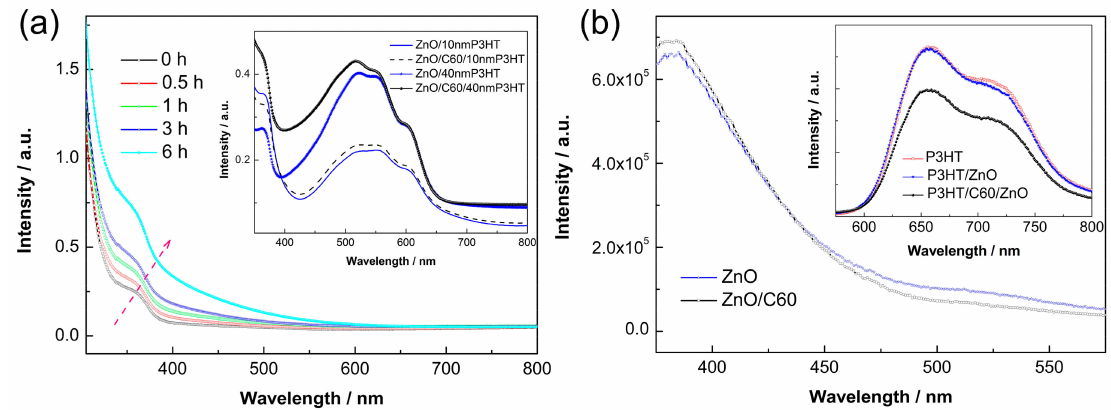
Figure 3. ( a ) UV–Vis spectra of ZnO thin film as a function of the C60 absorption time and the planar structures based on ZnO/P3HT (inset); and ( b ) PL spectra of the ZnO thin films and the planar structure based on ZnO/P3HT